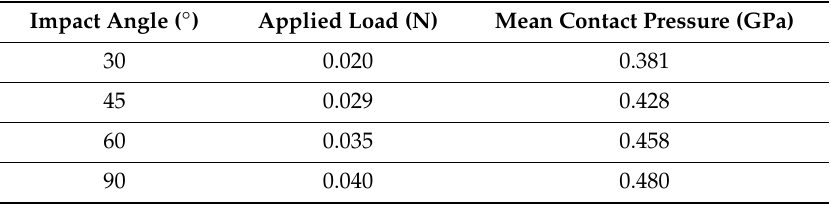
Table 2. Single particle impact mean contact pressure.